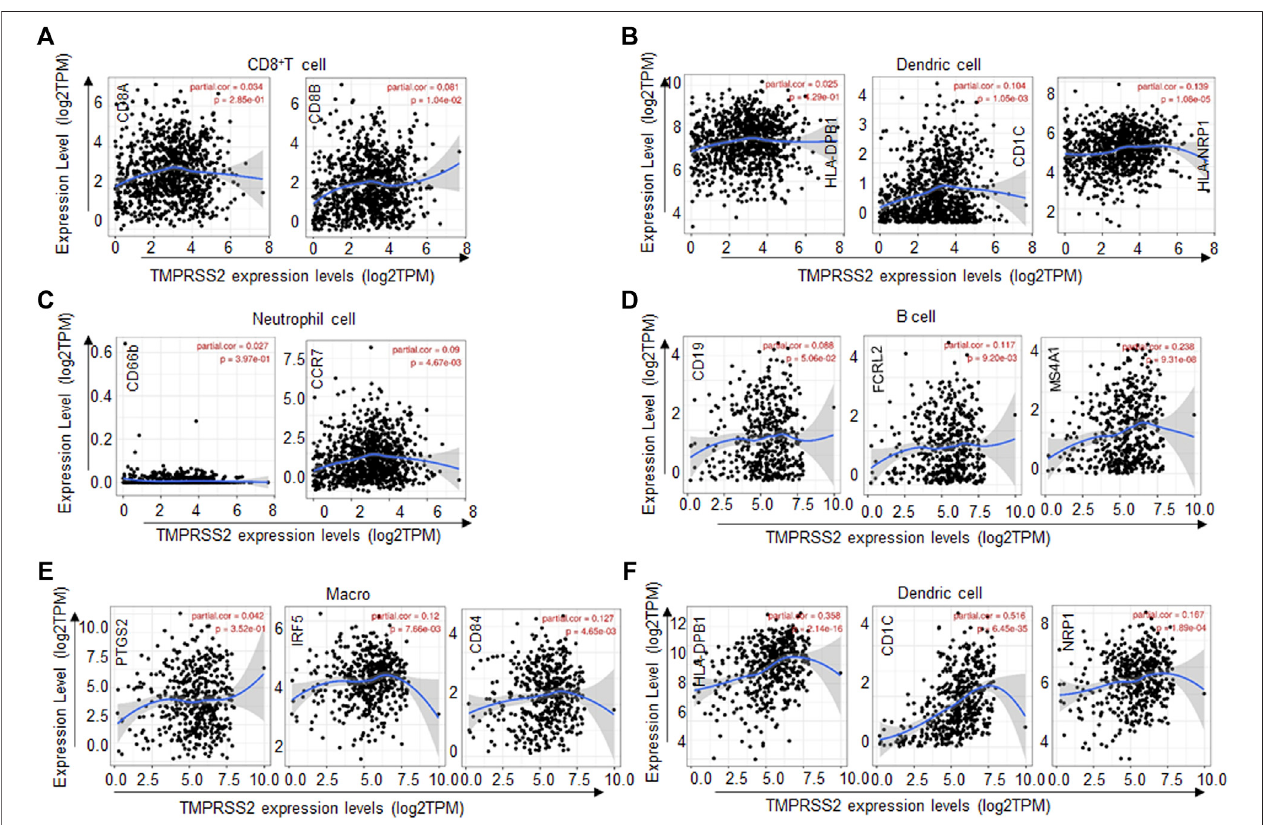
FIGURE 4 | TMPRSS2 expression correlated with the immune cell type markers in BRCA (breast invasive carcinoma) and LUAD (lung adenocarcinoma). The correlation of TMPRSS2 expression with gene markers of CD8 + T cells (A) , dendric cells (B), and neutrophil cells (C) in BRCA. The correlation of TMPRSS2 expression with gene markers of B cells (D) , macrophages (E), and dendric cells (F) in LUAD. Gene markers of CD8 + T cells including CD8A and CD8B, gene markers of B cells includingCD19,FCRL2,andMS4A1,genemarkersofdendriccellsincludingHLA-DPB1,CD1C,andHLA-NRP1,genemarkersofneutrophilincludingCD66band CCR7, gene markers of macrophages including PTGS2, IRF5, and